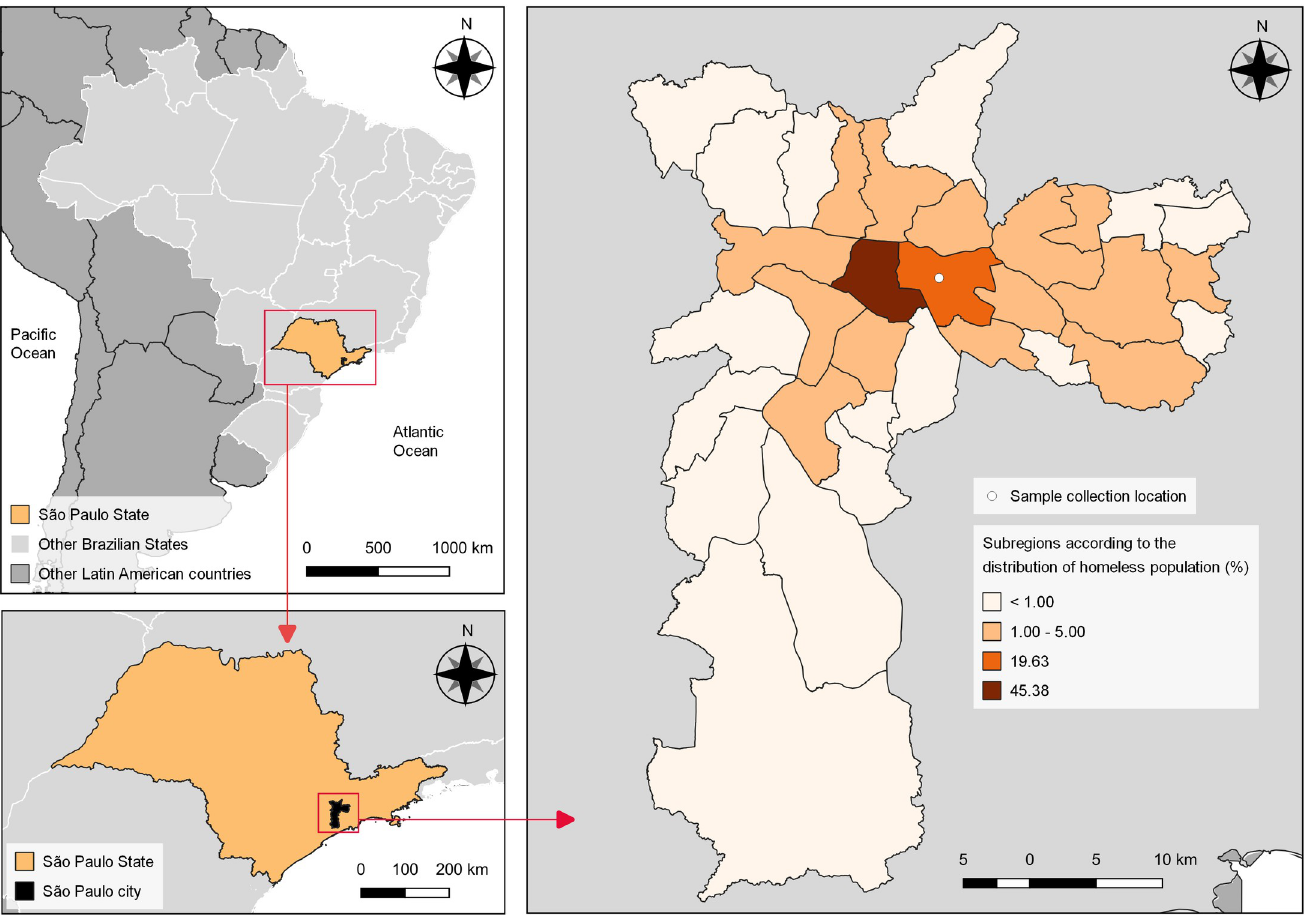
Fig 1. Geographical location of the shelter and distribution of homeless population as described in the latest S ã o Paulo city survey [12]. All maps are public domain (https://www.ibge.gov.br/geociencias/downloads-geociencias.html).